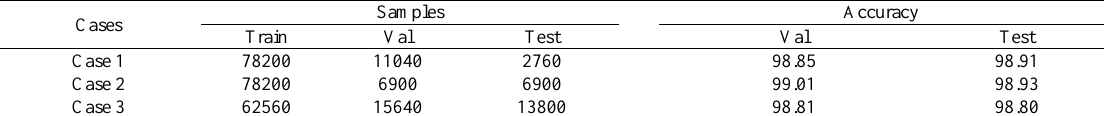
Table 4. Results on DHCD